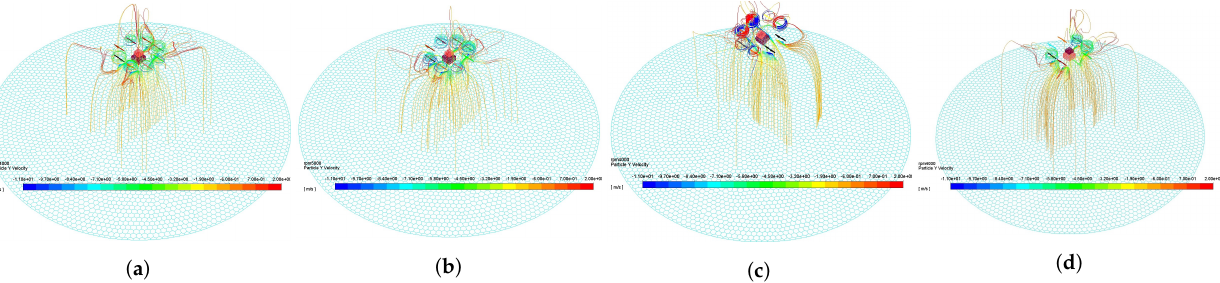
Figure 9. Droplet deposition trajectory under different flight states. The track color indicates the droplet velocity in Y − direction. ( a ) shows the UAV flying at 4e3 rpm, without tilt, and 3 m above the ground. ( b ) shows the UAV flying at 5e3 rpm without tilt, and 3 m above the ground. ( c ) shows the UAV flying at 4e3 rpm, 20 ◦ tilt, and 3 m above the ground. ( d ) shows the UAV flying at 4e3 rpm, without tilt, and 4 m above the ground.